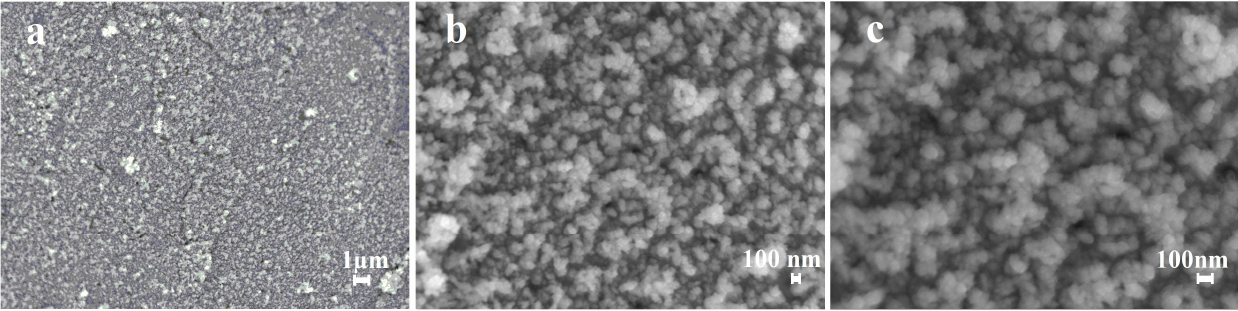
Figure 10. SEM images of synthesized palladium particles at magnifications of 5000 ( a ), 30,000 ( b ) and 50,000 ( c ).